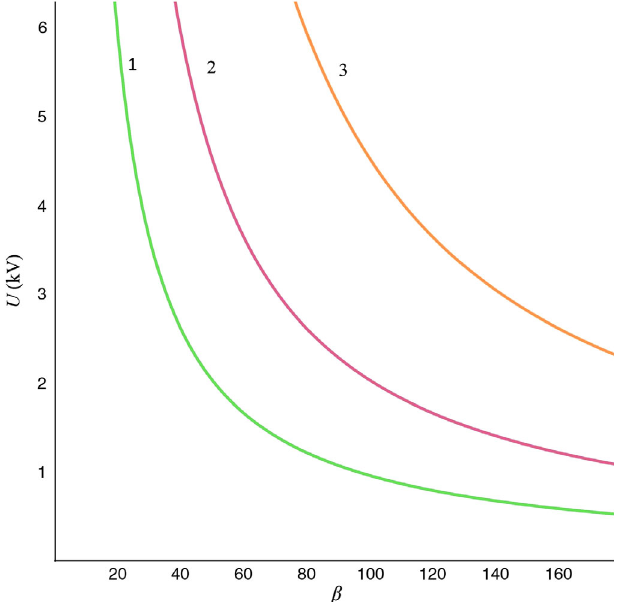
FIG. 1. Breakdown voltage U versus field enhancement factor β for a 50-ns delay time and a varied electrode gap spacing: d ¼ 10 (curve 1), 20 (curve 2), and 40 μ m